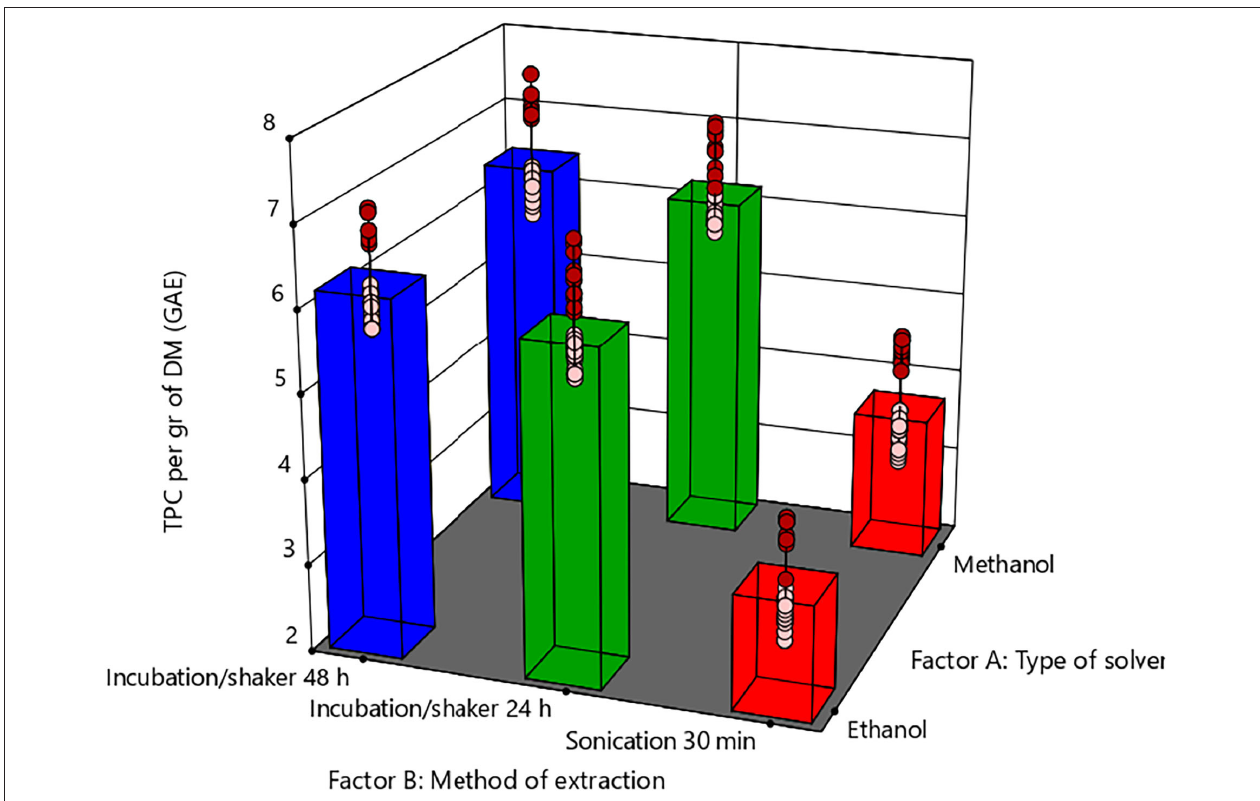
FIGURE 1 | Model graph and two-way ANOVA with blocking results between factor A (type of solvent − 90% ethanol or methanol) and factor B (extraction method). Pairwise comparison between best methods for extraction of phenolic compounds using methanol